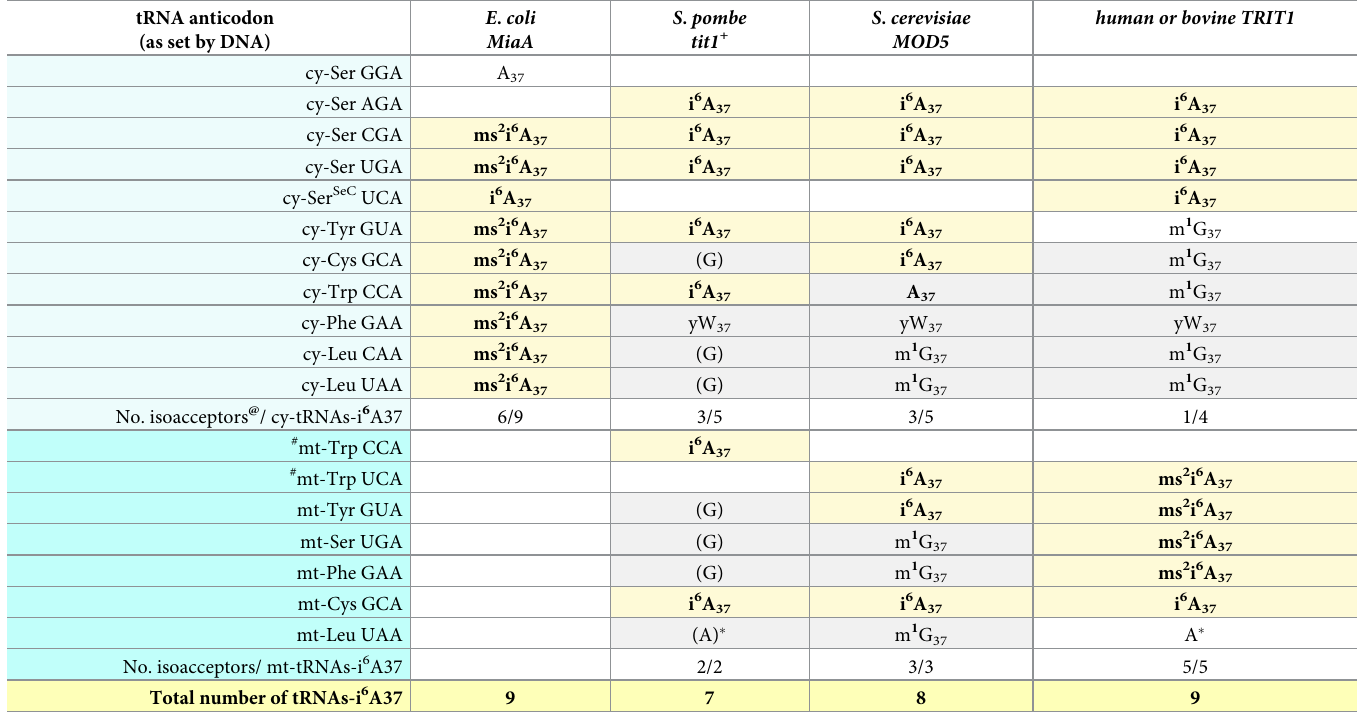
Table 1. tRNA-i6A37 identity variation among species, cytoplasm and mitochondria. tRNA anticodon (as set by